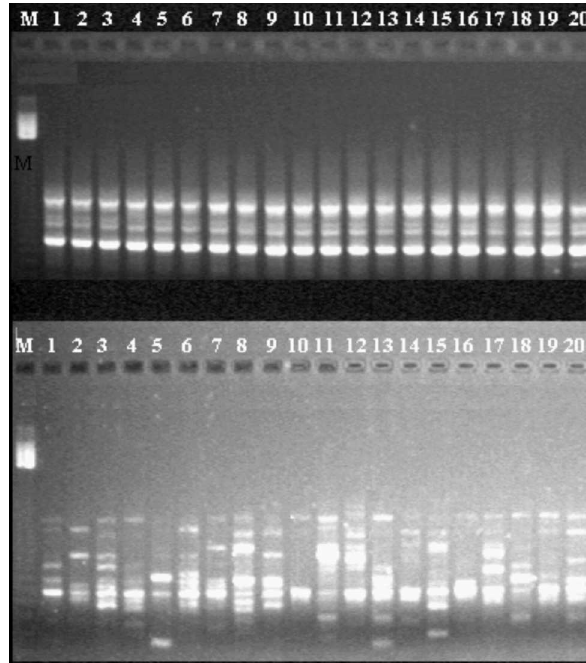
Figure 1 - Amplification profile of partial DNA coffee samples obtained with OPP-18 RAPD primer used alone (top) and in combination with re- striction enzyme Hae III (bottom).